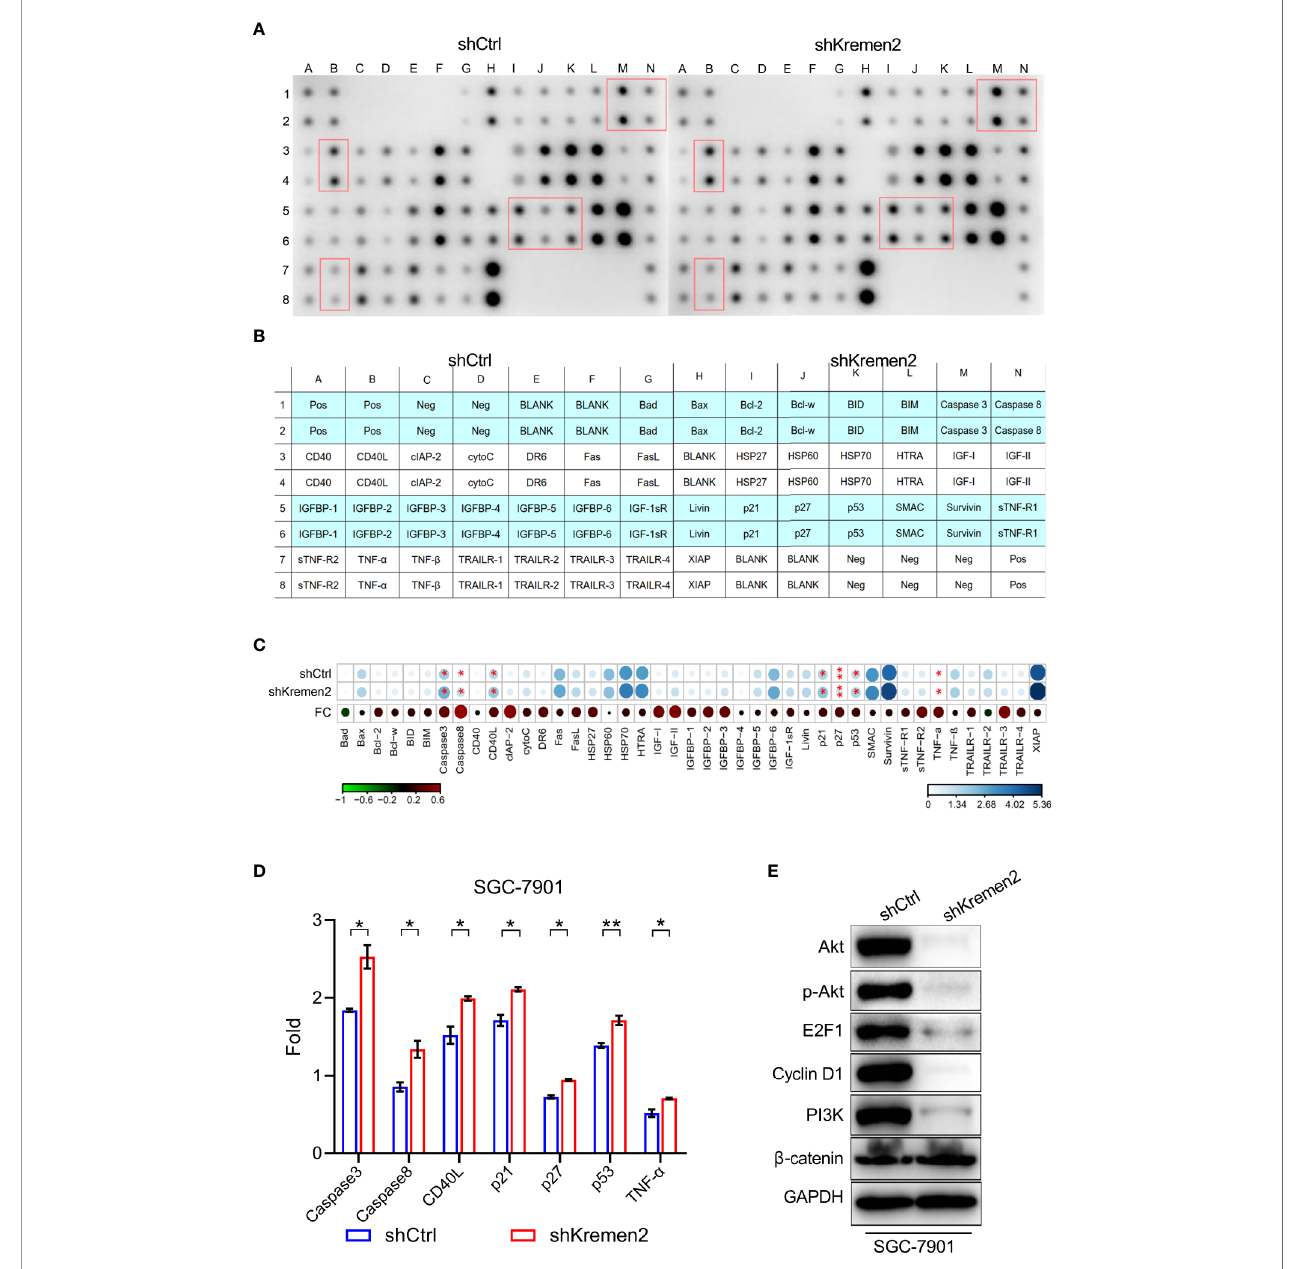
FIGURE 5 | Kremen2 knockdown inhibited survival of GC cells through the PI3K/Akt pathway. SGC-7901 cells were stably transfected with Lenti-shKremen2 or Lenti-shCtrl and cell lysate was analyzed using antibody array and western blot. (A) The spots of apoptosis antibody array after knockdown of Kremen2. (B) The position of each protein in the antibody array. (C) Fold change of each protein in the antibody array. (D) Semi-quantitative analysis of change of caspase 3, caspase 8, CD40L, p21, p27, p53 and TNF- a following Kremen2 knockdown. (E) Kremen2 knockdown down-regulated expression of p-Akt, Akt, E2F1, PI3K and cyclin D. * P < 0.05; ** P < to inhibit cyclin-CDK complex to block cell cycle progression and celldivision(21).Therefore,weguessthatKrm2promotescellcycle progression by regulating p21 and p27.